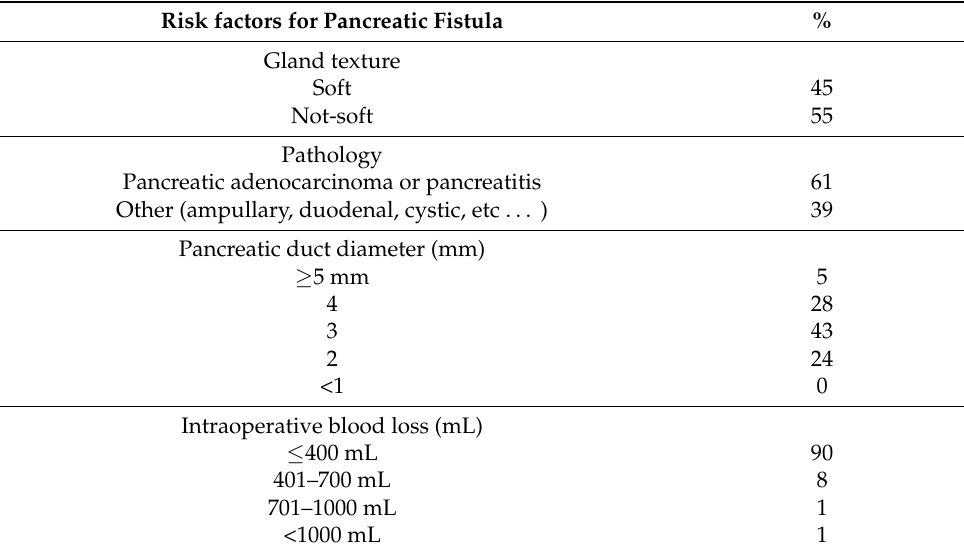
Table 3. Patients’ stratification according to the Fistula Risk Score